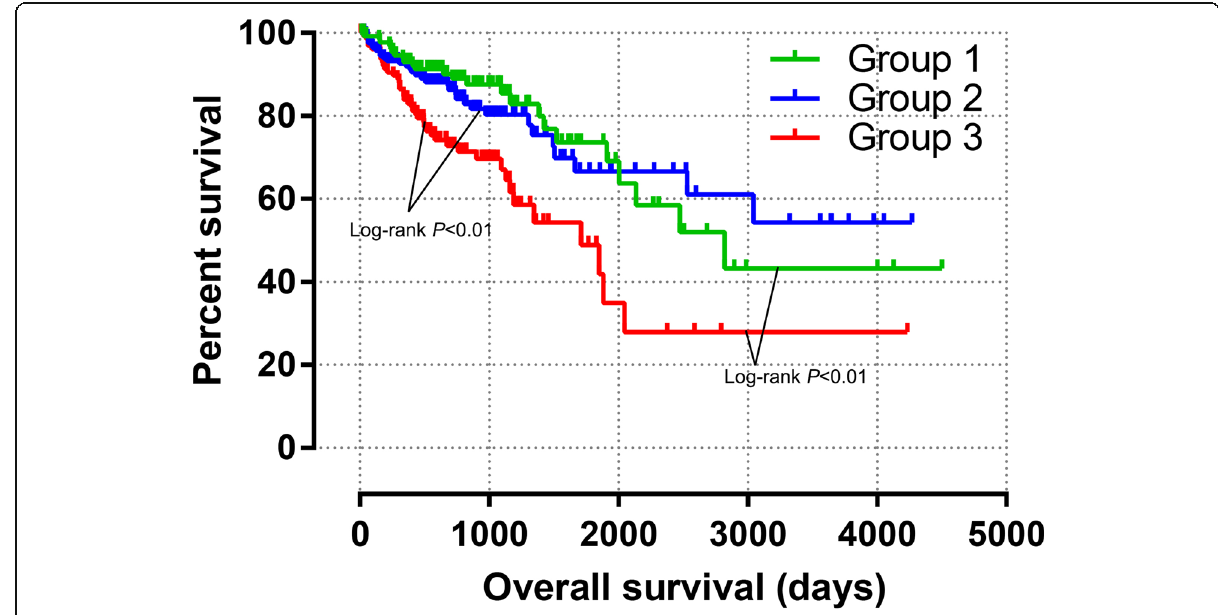
Fig. 6 Joint-effects analysis of GSTM1 and GSTM2 expression level combinations